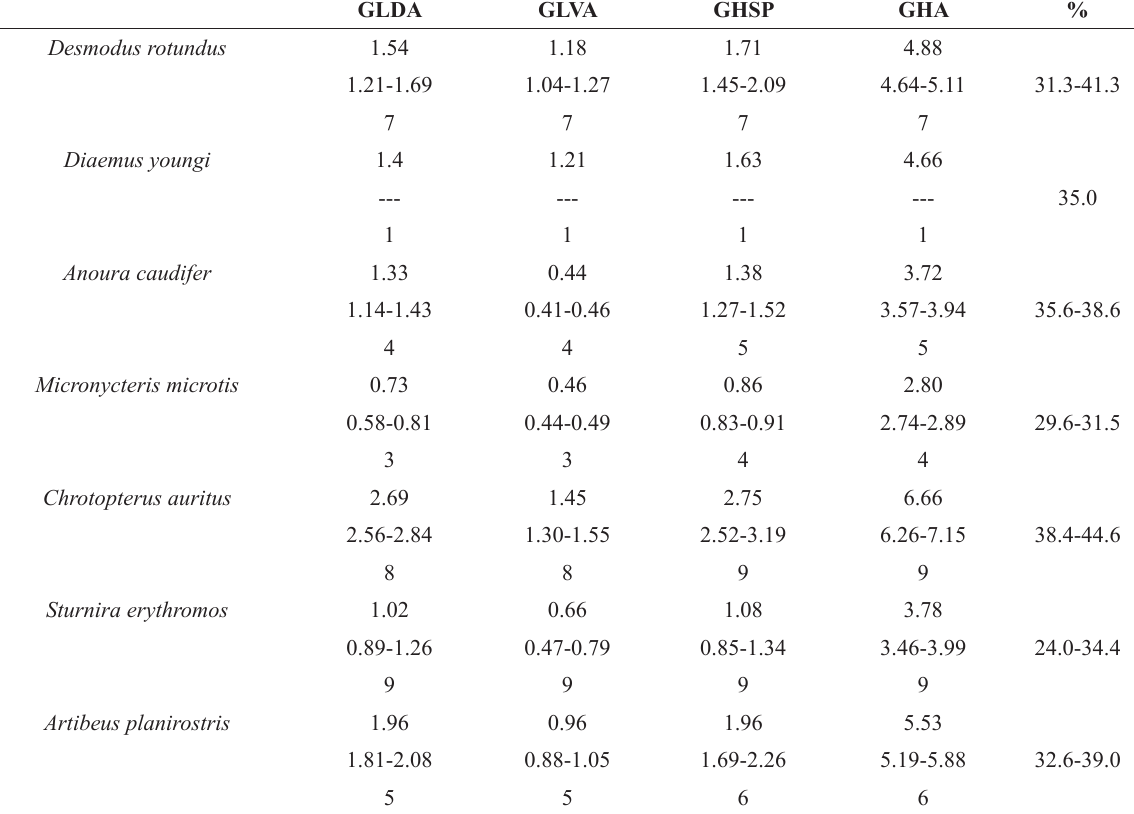
Measurements in mm, mean, standard deviation, and number of specimens of each analyzed species. Acronyms: GLDA, greatest length of dorsal arch of atlas; GLVA, greatest length of ventral arch of atlas; GHSP, greatest height of spinous process of axis; GHA, greatest height of axis; %, percentage of GHSP in